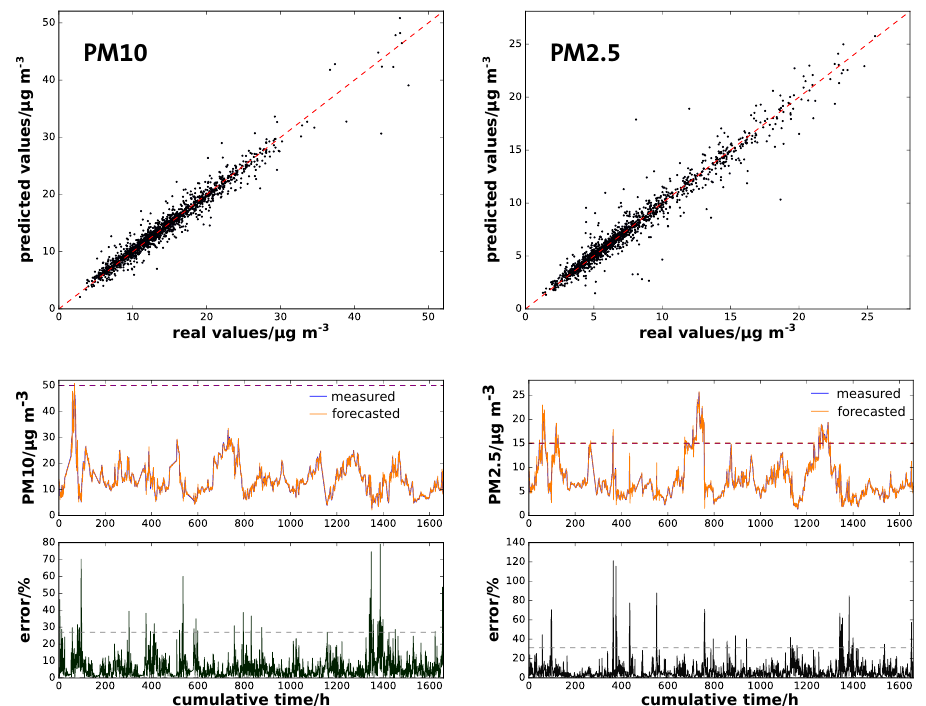
Figure 4. Dispersion, concentration, and errors over time dependencies for the third test iteration of forecasting without seasonality decomposition with monthly seasonality decomposition. Dispersion plots: R 2 = 0.932 for PM10 and R 2 = 0.917